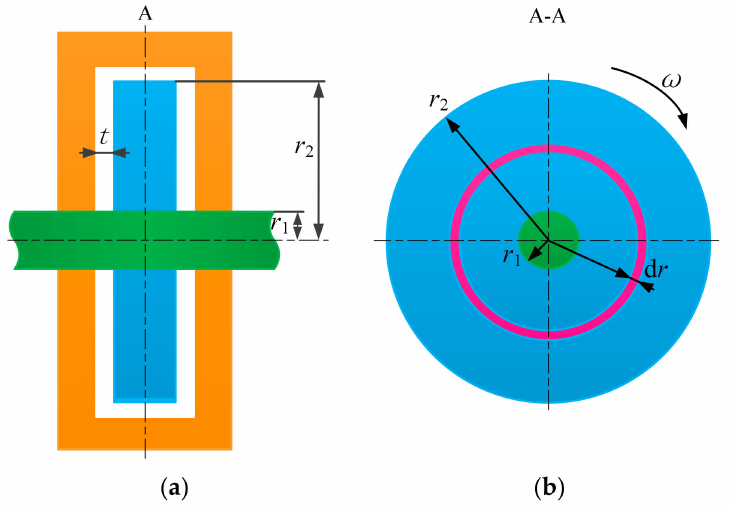
Figure 3. Schematic diagram of brake disc. ( a ) Front view and ( b ) cross-sectional